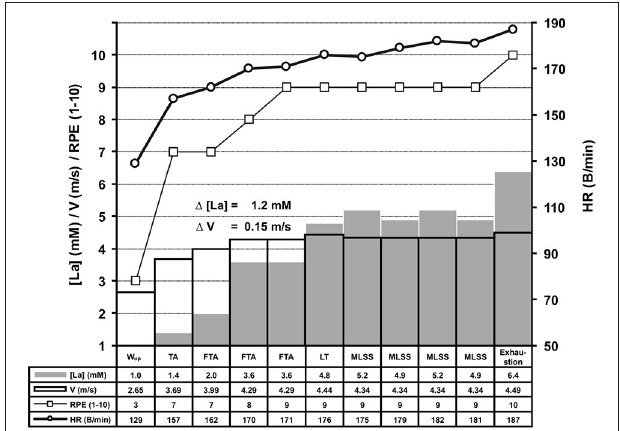
FIGURE 2 | Experimental protocol of the ILT-Test. The basic experimental protocol was identical on the treadmill and bicycle ergometer (for detailed information see Figure 1 ). After the warm-up (W up ), threshold adjustment (TA), and fine threshold adjustments (FTA), a steep arterial lactate accumulation occurred at the lactate threshold (LT) ( 1 [La] = 1.2mM), in response to a slight increase of treadmill speed. The arterial lactate accumulation stopped after a small workload (WL) reduction (0.1 m/s), representing the MLSS W , and rapidly rose again after another WL increment (exhaustion). Because each WL adjustment based on the lactate level from the previous 4min step, the duration of the test can vary intraindividually (data not shown). HR, heart rate; [La], arterial lactate concentration; RPE, rating of perceived exertion; V, treadmill velocity.